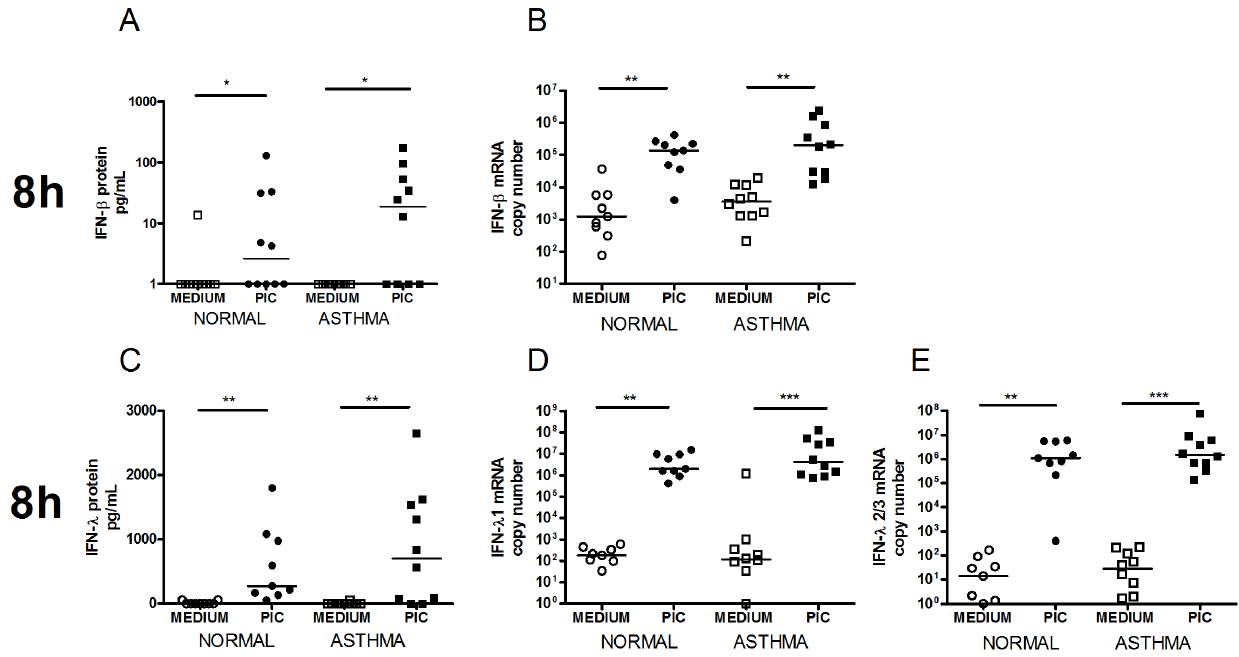
Figure 1. TLR3 induced type I and III IFN in HBECs. Figures depict IFN- b protein [A], IFN- b mRNA [B], IFN- l protein [C], IFN- l 1 mRNA [D] and IFN- l 2/3 mRNA [E] at 8 h following Poly I:C stimulation. Squares represent asthmatics and circles represent non-asthmatics. *=p , 0.05, **=p , 0.01, ***=p , 0.001.